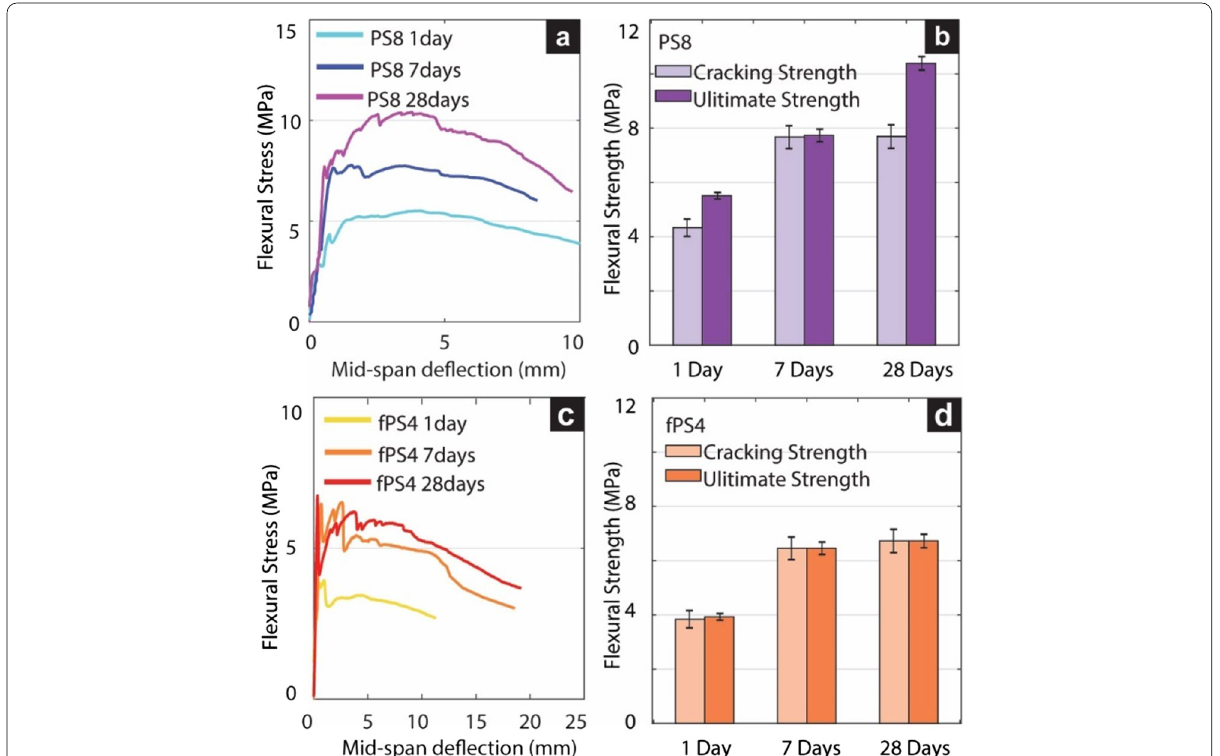
Fig. 7 Load–mid-span deflection curves of a PS8 and b fPS4 at different curing ages. Flexural strength for MPC mortar with b PS8 and c